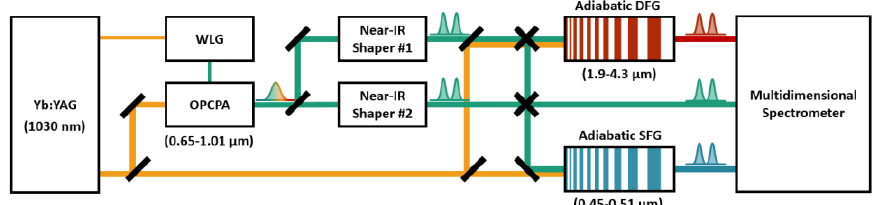
Fig. 1. Yb:YAG amplifier seeds WLG and pumps the OPCPA, ASFG, and ADFG stages. A portion of the WLG continuum (0.65- 1.01 μm) is amplified in a two -stage OPCPA to 200- μJ pulse energy. The pulses are shaped in the near-IR before upconversion and downconversion by ASFG and ADFG, respectively. Each of the two shaper outputs can be used for generation of shaped UV/vis, near-IR, or mid-IR pulses to create hyperspectral pulse sequences as needed for a particular